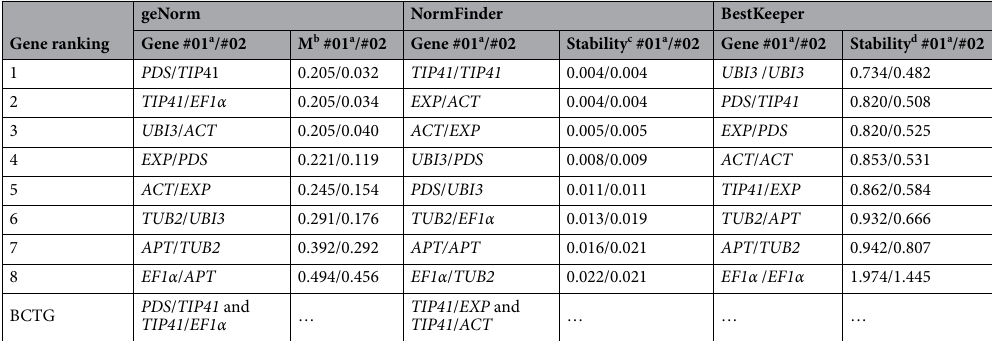
Table 2. Analyses of expression stability of eight candidate reference genes for expression normalization involving the pathosystem tomato ‘Hawaii 7996’ and virulent/compatible and avirulent/incompatible Ralstonia solanacearum isolates at different sampling collection times. BCTG best combination of two genes. a Global Interaction #01 and Global Incompatible Interaction #02, as described in Table 1. b M = average expression stability, calculated using the algorithm geNorm. c Stability = gene expression stability calculated by intragroup and intergroup variation using the algorithm NormFinder. d Stability = standard deviation (std dev [± CP]) calculated using the algorithm BestKeeper. Significant values are the ones displaying values < 1.0. All genes showed significant p value (= 0.001) using Pearson’s correlation